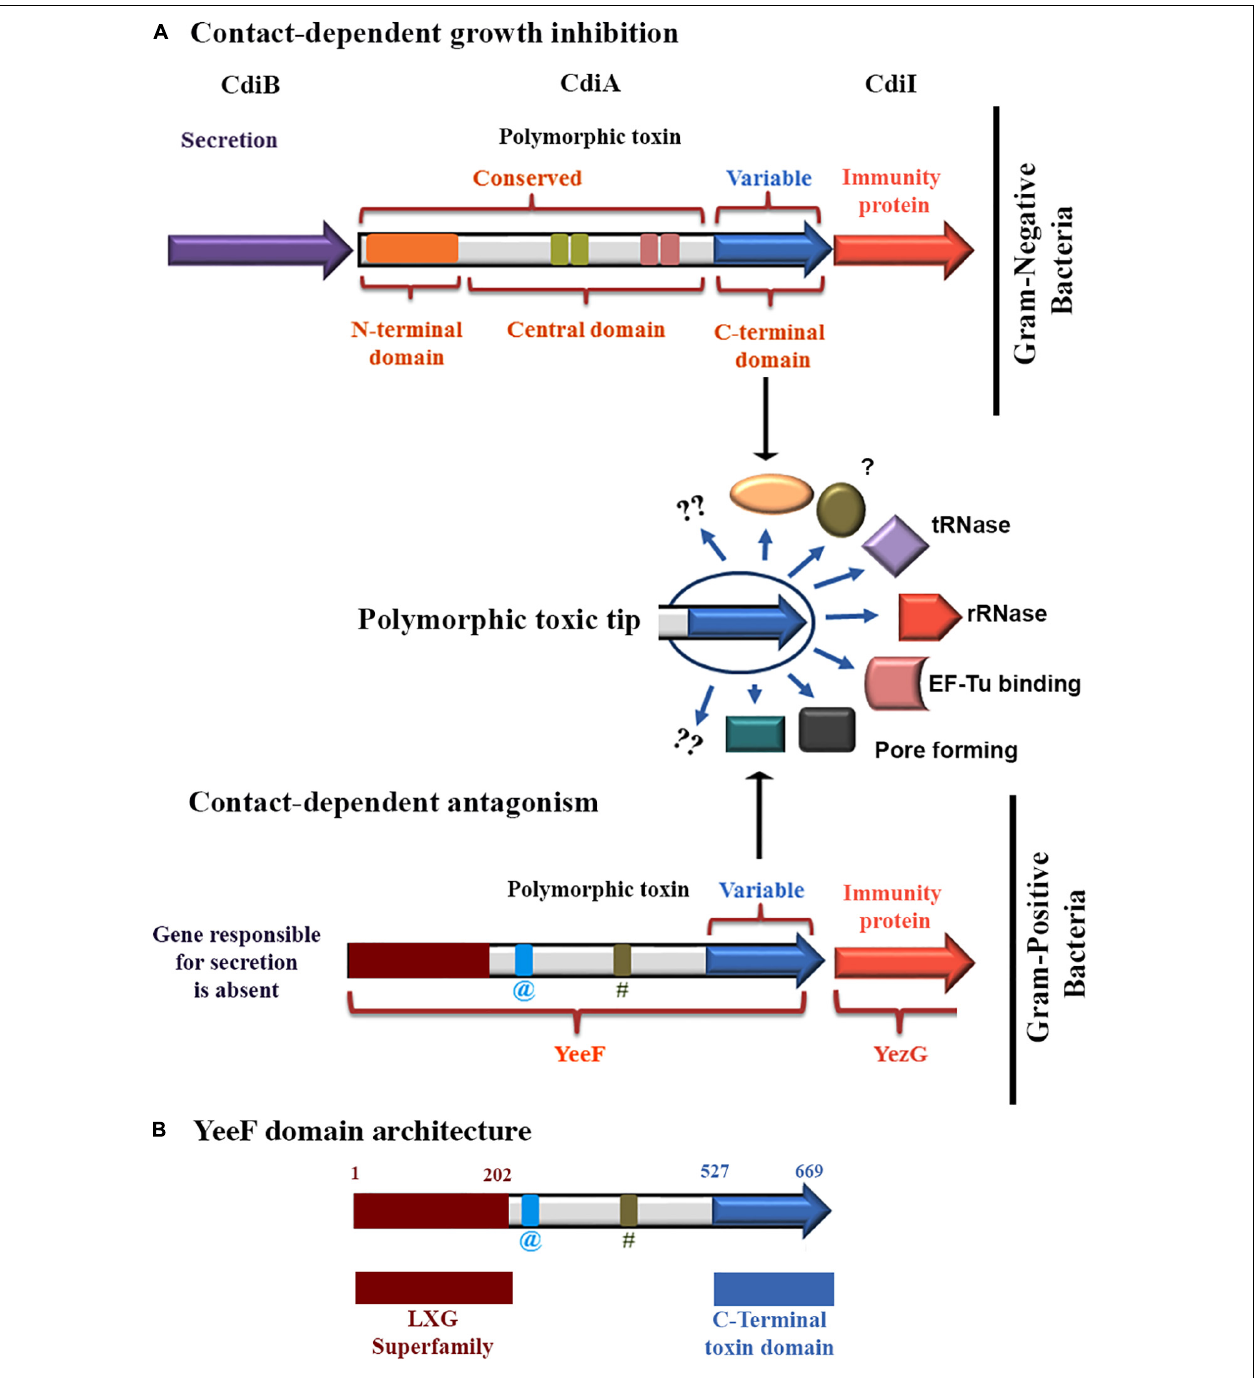
FIGURE 1 | A schematic representation of the polymorphic toxin systems. (A) The schematic representation depicting the organization of polymorphic toxin system involved in contact-dependent growth inhibition in Gram-negative bacteria. An optional dedicated transport system may be encoded in the vicinity of toxin/immunity genes of the toxin. In a defined family, the polymorphic toxin is composed of a conserved N-terminal region having a transporter domain and a variable C-terminal region that codes for the diverse toxin modules. Apart from the transporter domain, the longer central region shows a high variation in the length and contains various combinations of domains/repeats like filamentous hemagglutinin, recombinant hot spot, etc. This central region also presumably helps in toxin display on the cell surface. Operon organization of a polymorphic toxin system involved in contact-dependent antagonism in Gram-positive bacteria. (B) YeeF domain architecture of YeeF toxin. The N-terminal region has a similarity with conserved LXG domain superfamily of Pfam PF04740, which is required for the secretion of toxin by type VII secretion system (Whitney et al., 2017). The C-terminal toxic module is annotated as a putative DNA/RNA non-specific endonuclease. @ Coiled-coil region; # Low complexity region. Of note that the domain architecture representation is not as per the